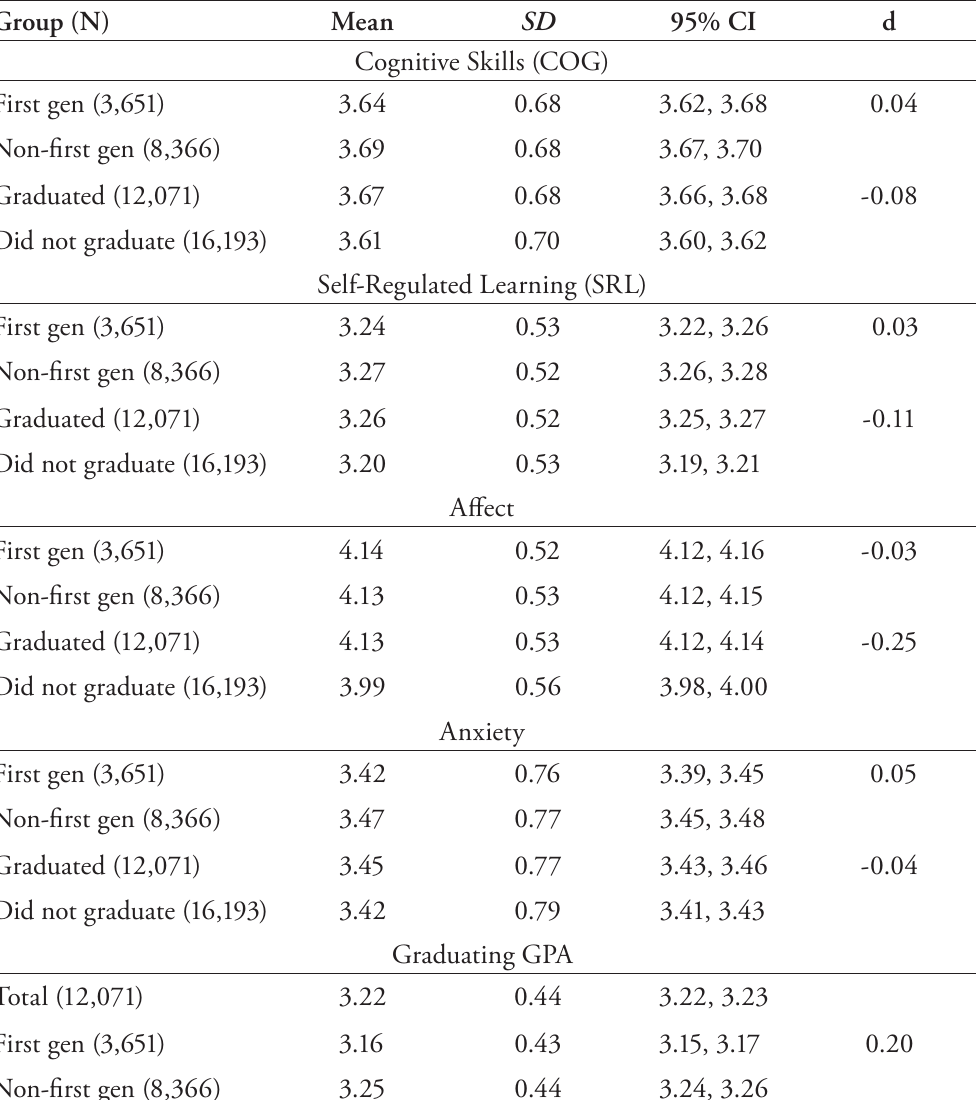
Table 1. First- Generation Status and Graduation Status Group Comparisons on Primary